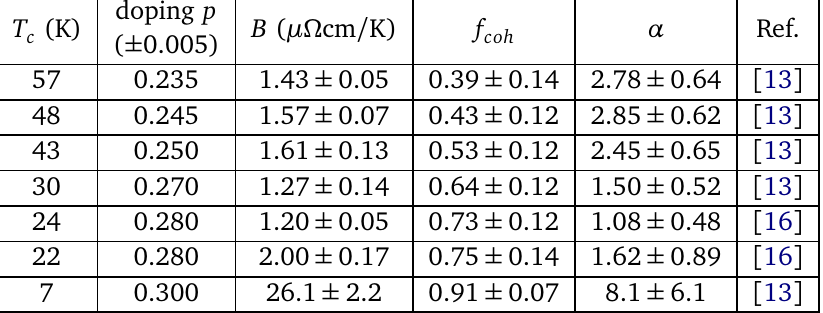
Table 3: Estimate of the prefactor α in the T -linear resistivity term associated with the incoherent sector. B is copied from Table 1 and f the text. Parameter α is determined by comparing Eq. (26) and (27). The error bars for f were determined from the error bars in n coh calculated as composite deviations coming from standard deviations in f resistivity parameter B . The high error bars for the lower T ) used in Eq. (26) coupled with the uncertainty in f low value of ( 1 − f coh